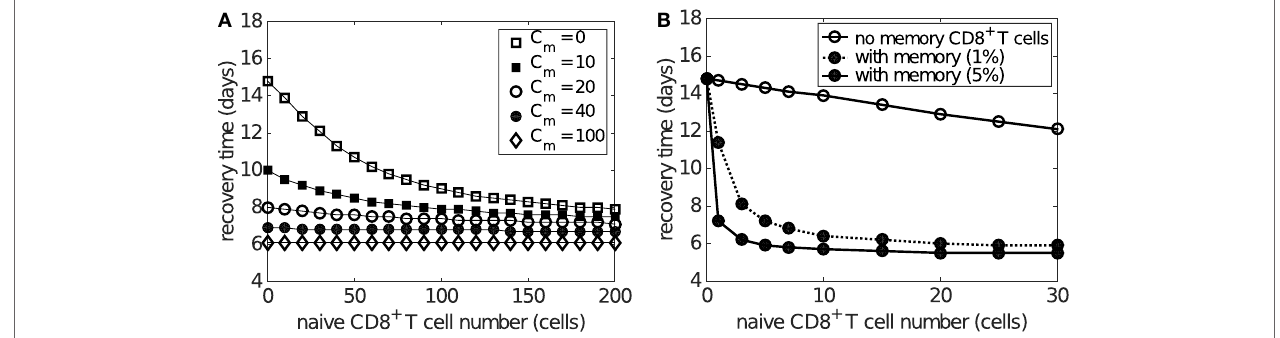
FIGURE 8 | Effects of naive and memory CD8 + T cells on viral clearance . Recovery time is defined to be the time when the viral load falls to 1 EID 50 /ml. (A) demonstrates that varying the number of memory CD8 + T cells ( C m ) reduces the recovery time for any naive CD8 + T cell number (i.e. C n (0)). Note that saturation is observed for C m > 100 where the recovery time is about 6days, independent of the naive cell numbers. (B) demonstrates how the presence of preexisting memory CD8 + T cells (solid dots) leads to a shorter recovery time when compared to the case where no memory CD8 + T cells are established (open circles). Note the time scale difference in (A,B) . This simulation is based on the assumption that the level of preexisting memory CD8 + T cells is assumed to be either 1 or 5% (as indicated in the legend) of the maximum effector CD8 + T cell number due to primary viral infection. The memory cell number (which is not shown in this figure) is about 30 times as many as the naive cell number shown in the figure, i.e., 30 naive cells result in about 900 memory cells before reinfection.